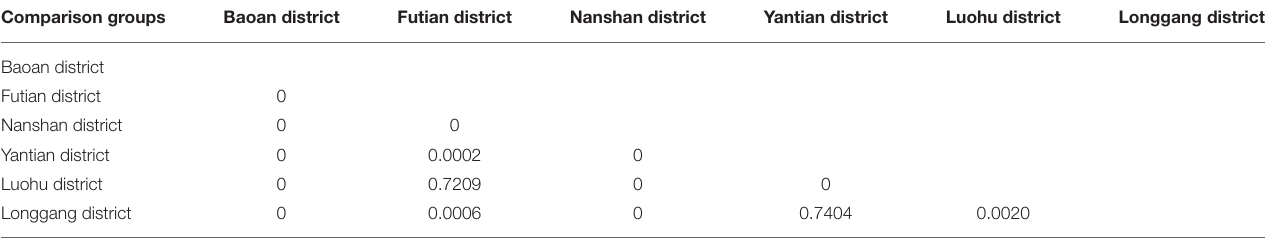
TABLE 2 | The P values of multiple comparisons for different districts (LSD).